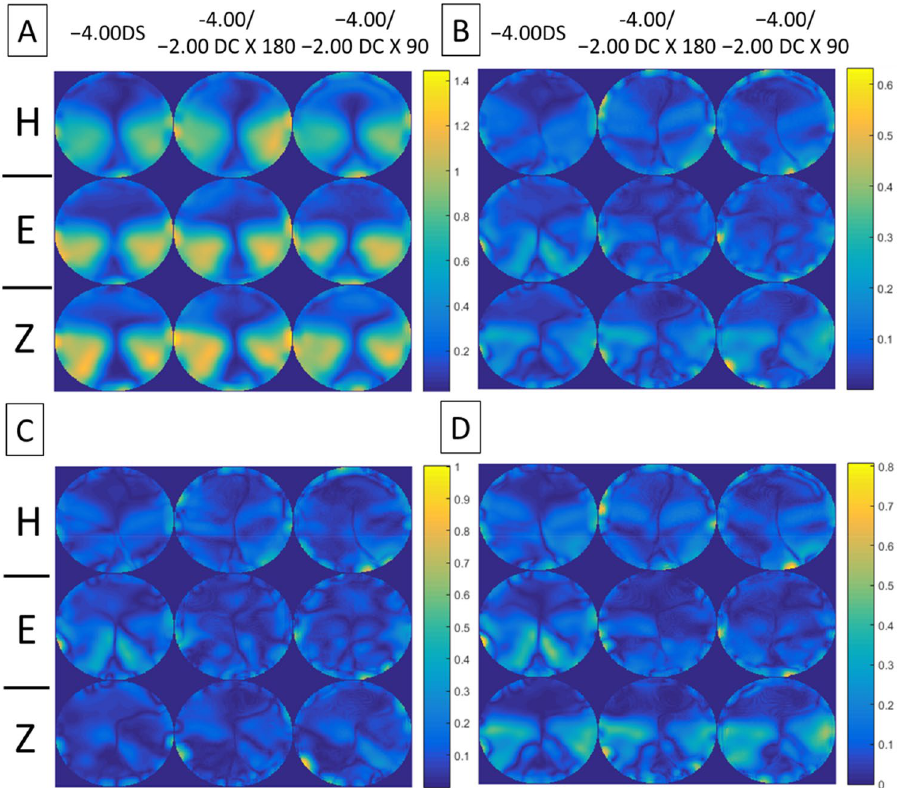
Figure 6. Error maps of vectorial cylinder, (cid:31) J v . ( A ) Mean and ( B ) standard deviation of the error maps for four lenses (2 models × 2 corridor lengths) with the same prescription (columns) from the three lens manufacturers (rows: H Hoya, E Essilor, Z Zeiss). ( C ) and ( D ) show mean absolute differences of the error maps for PALs of different models and corridor lengths, respectively. Note that the scales of color-coded maps are